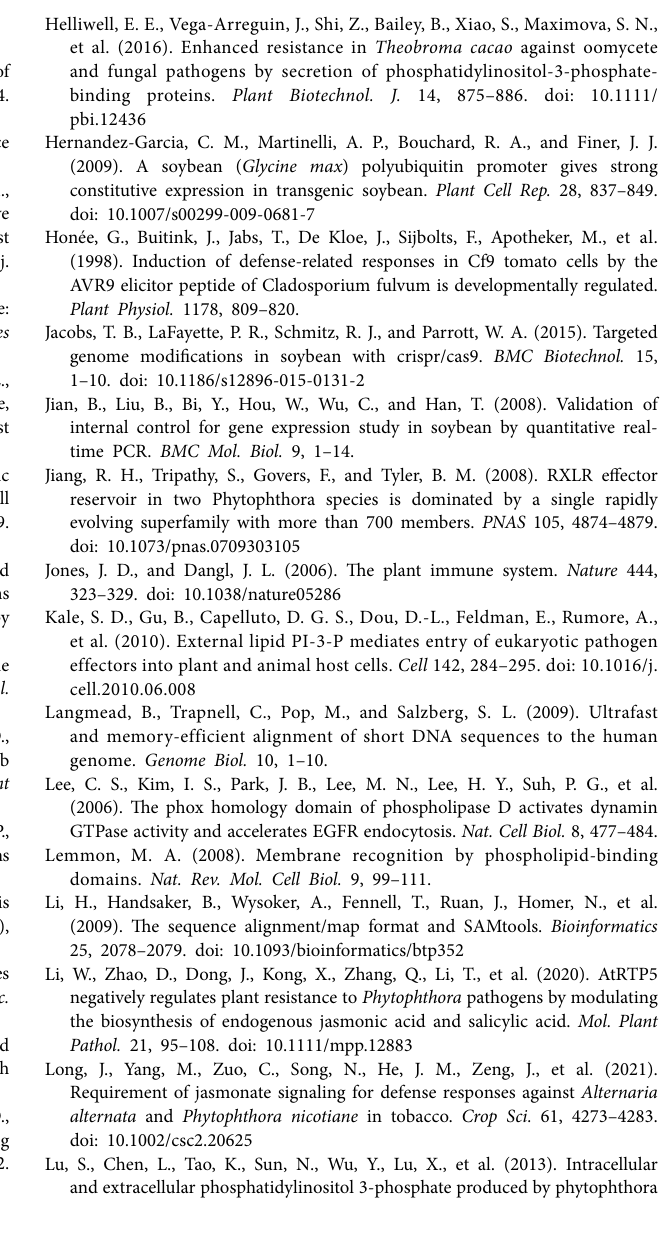
Supplementary Table 1 | Design of RNA sequencing experiment, showing the genotype, category, treatment, and number of replicates for each RNA library sequenced. Supplemental Table 2 | FASTQ run reports and summary of RNA sequencing. Supplemental Table 3 | Genes with transcript levels differing among mock- inoculated genotypes. Supplemental Table 5 | Hormone measurements in soybean lines. Letter groups denote a significant difference between Control and GmPH soybean. Supplemental Table 6 | List of primers and sequences used in this